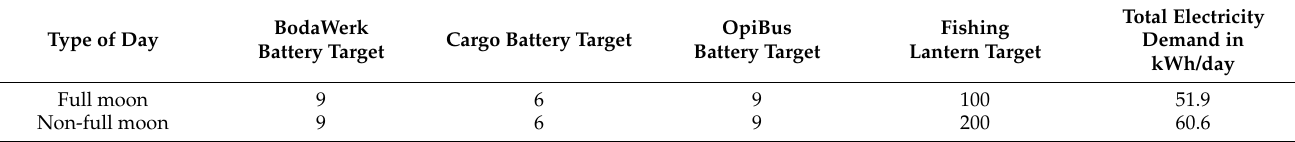
Table 5 . System design scenario for load profile generation. Table 5. System design scenario for load profile generation.